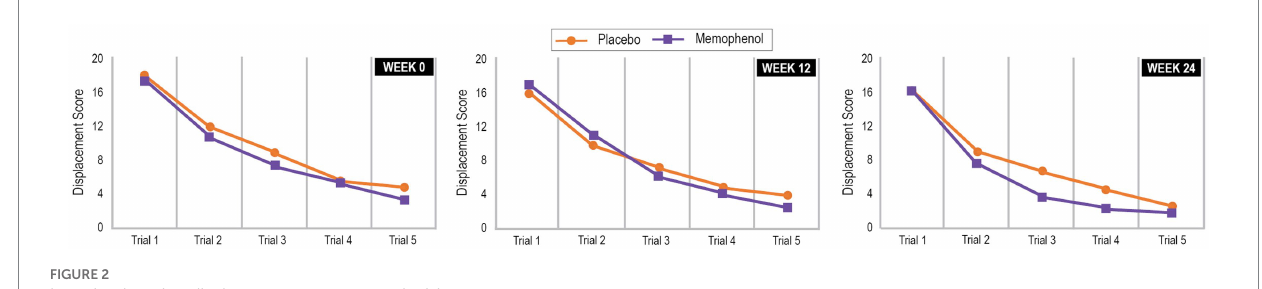
FIGURE 2 Location learning displacement scores at each